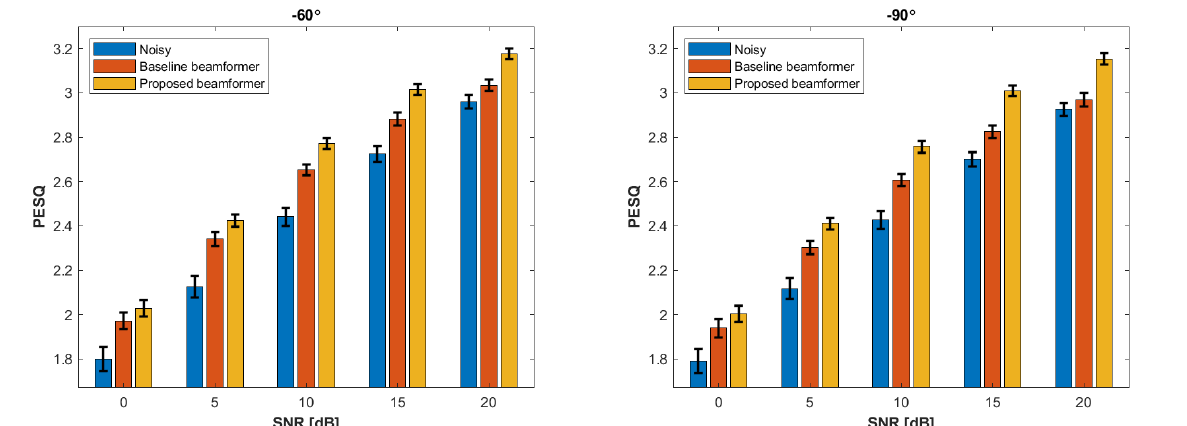
Figure 4. Average perceptual evaluation of speech quality (PESQ) scores and 95% confidence intervals for the noisy input and the outputs of the baseline and proposed beamformers depending on the azimuth of the desired source in diffuse noise environments with an RT60 of 300 ms.